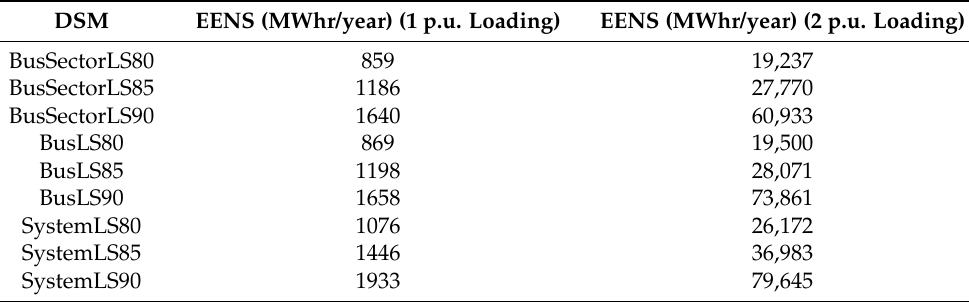
Table 3. The reliability impact of all the DSM